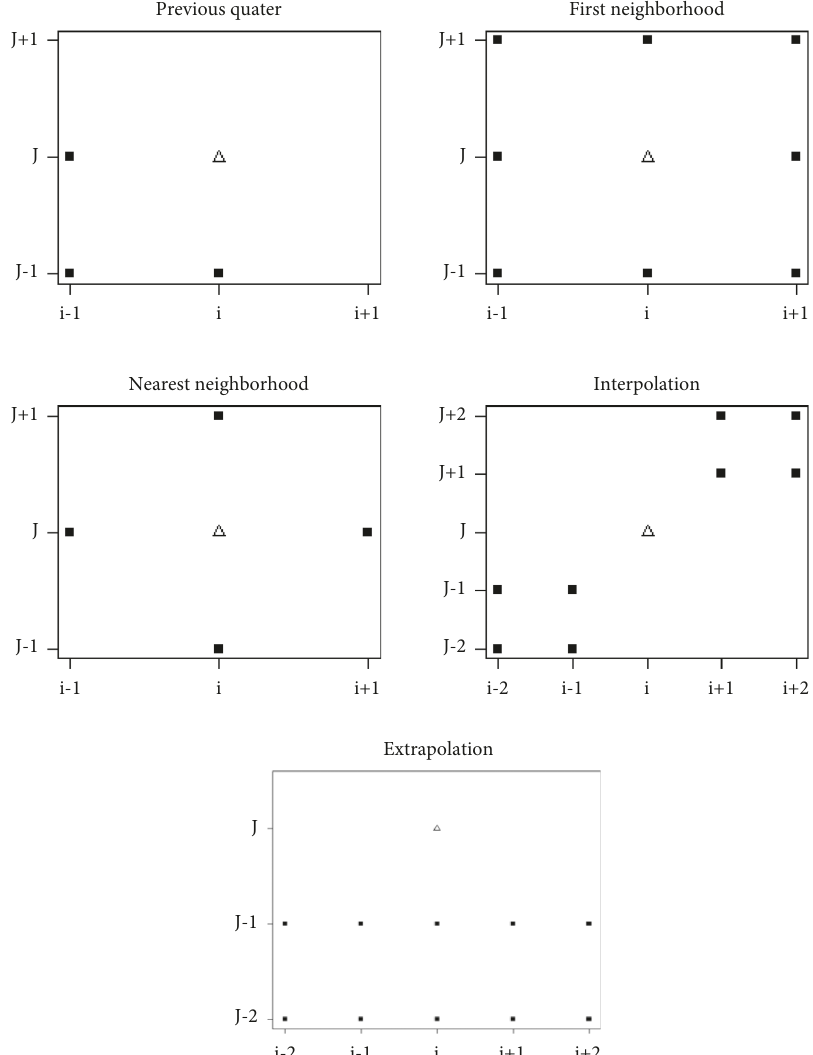
Figure 1: Locations of observations ( ■ ) and missing value ( △ ) . Upper figure shows three schemes for interpolation while lower figure shows interpolation and